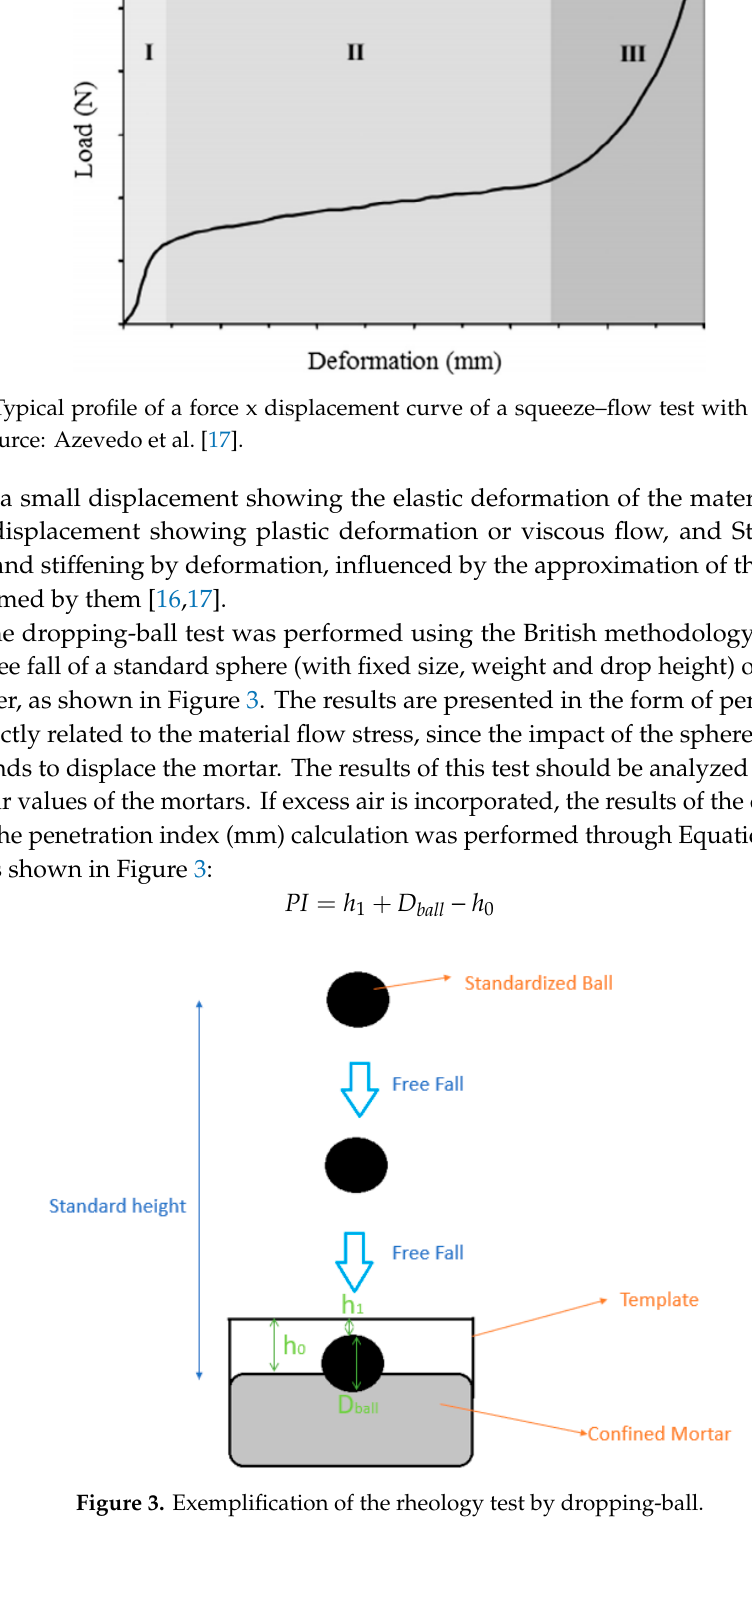
Figure 1. Exemplification of the rheology test by squeeze–flow. ( a ) Molded Sample and ( b ) compression in progress.